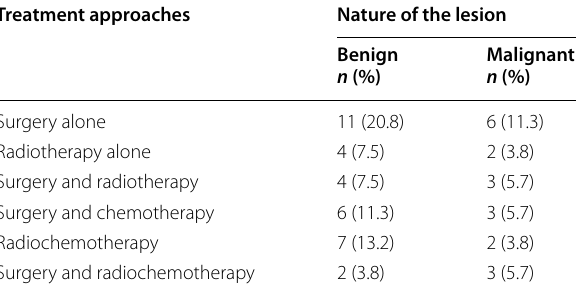
Table 4 Treatment modalities offered to the patients included in the study ( N =